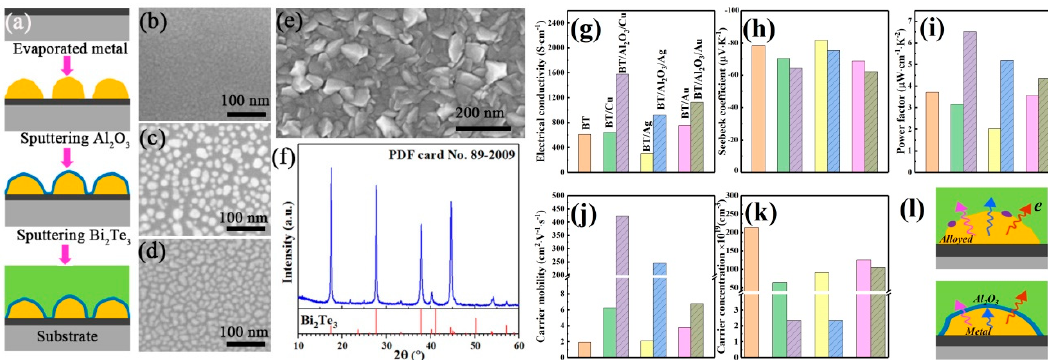
Figure 1. Preparation, characterization and thermoelectric performance of Bi 2 Te 3 -based films. ( a ) Preparation of Bi 2 Te 3 -based films in the order of depositing metal, Al 2 O 3 and Bi 2 Te 3 ; ( b ), ( c ) and ( d ) are the top view of Cu, Ag and Au, respectively; ( e ) the surface morphology of Bi 2 Te 3 ; ( f ) the XRD pattern of Bi 2 Te 3 film; ( g ) electrical conductivity; ( h ) Seebeck coefficient; ( i ) power factor; ( j ) carrier mobility; ( k ) carrier concentration; ( l ) crossing and scattering of electrons at the interface. BT represents Bi 2 Te 3